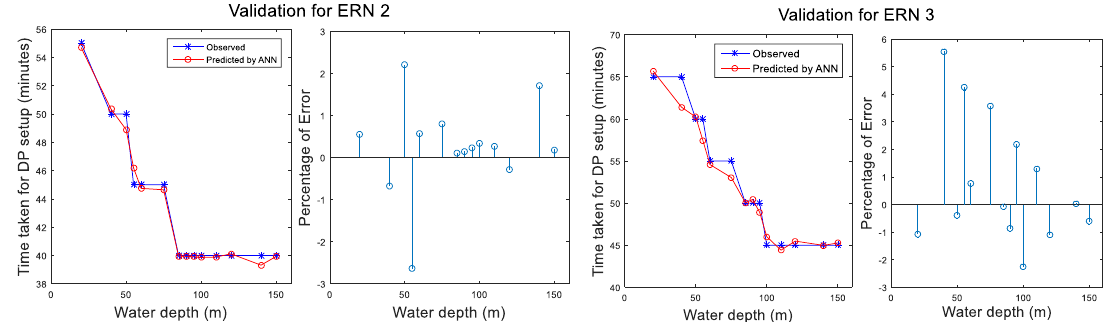
Figure 5. Comparison plot for observed and ANN predicted values (Time for DP setup).